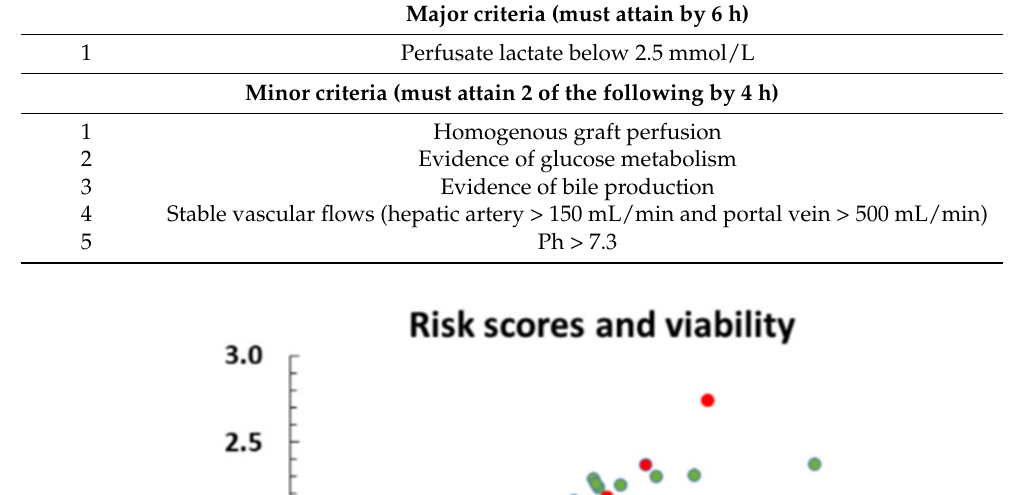
5 Table 1. Birmingham viability criteria.